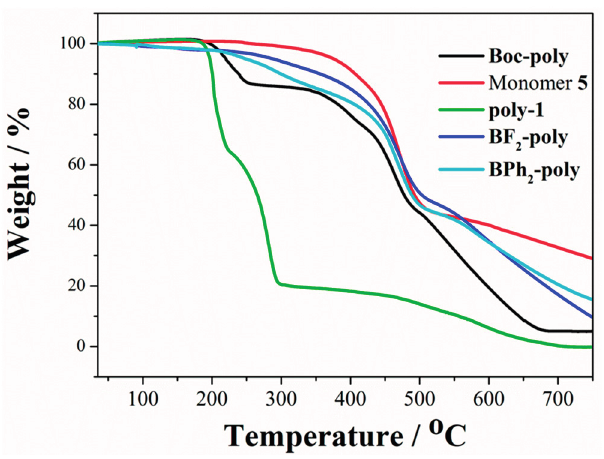
-poly ( a ) and BPh 2